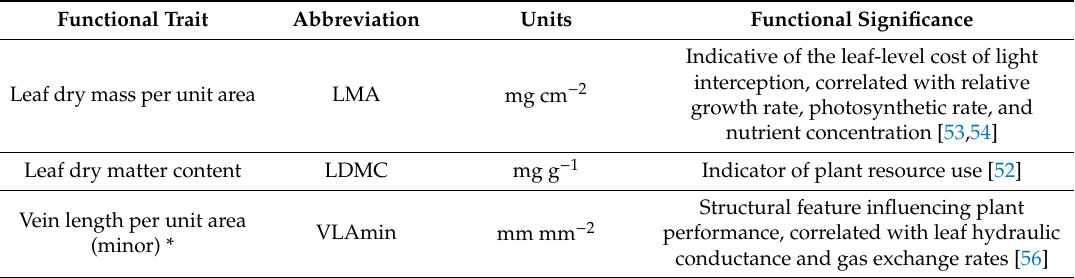
Table 1. Functional traits used to calculate functional niches and community invasibility of plant communities and related functional